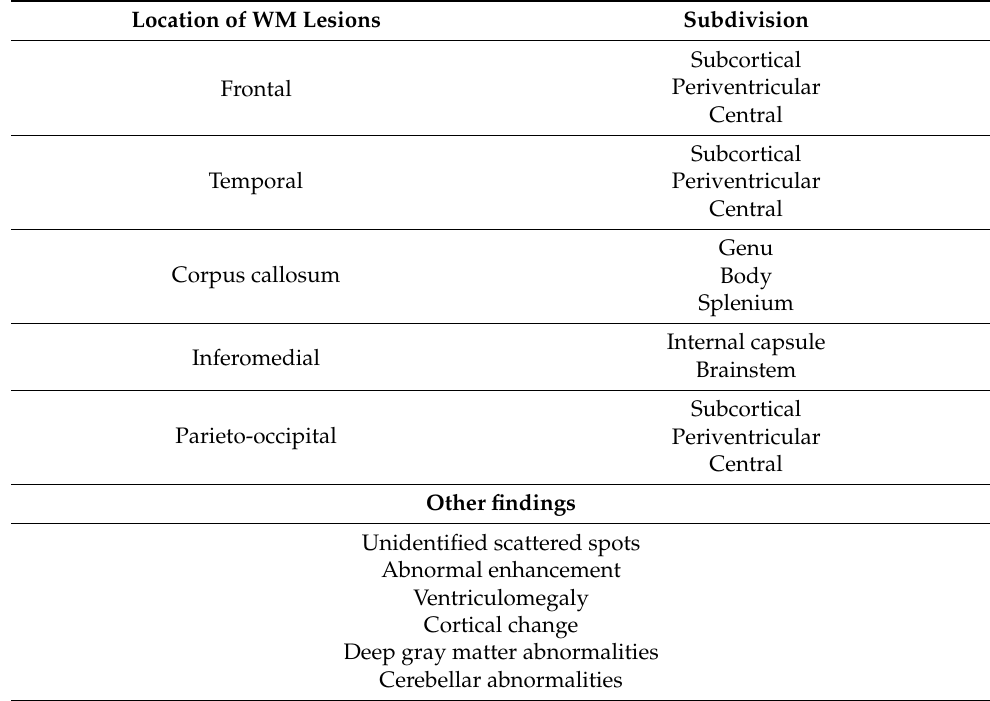
Table 1. Division of white matter lesions on brain MRI findings.